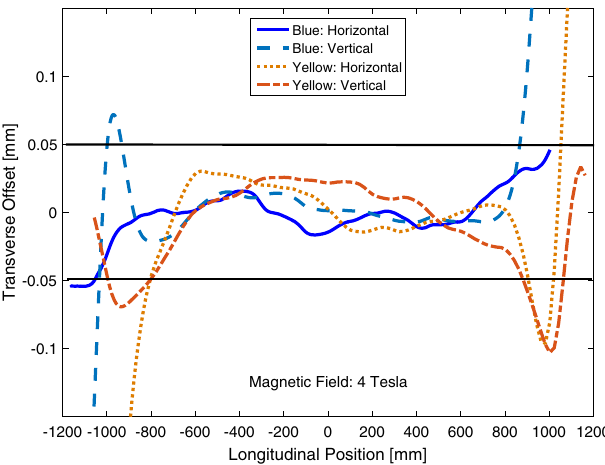
Magnetic Field: 4 Tesla